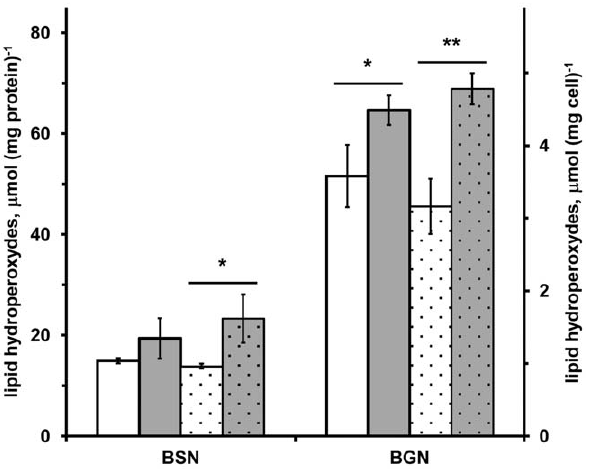
Figure 1. Lipid hydroperoxide concentration in A. vinelandii cells. Lipids hydroperoxides were detected, after incubation with FOX 2 reagent, in wild-type (UW136; white bars) and in rhdA null mutant (MV474; grey bars) A. vinelandii strains grown in Burk’s medium containing sucrose (BSN) or gluconate (BGN) as carbon source. Data are normalized relative to the cell mass (dotted bars) and to the protein amount (not-dotted bars) detected in 10 mM Tris-HCl 0.1 M NaCl (pH 8) extracts of cell-samples from the same growths, and are the mean of three independent replicates 6 standard deviation. Differences significant for P , 0.05 (*) or P , 0.01 (**) are indicated (Student’s t test).